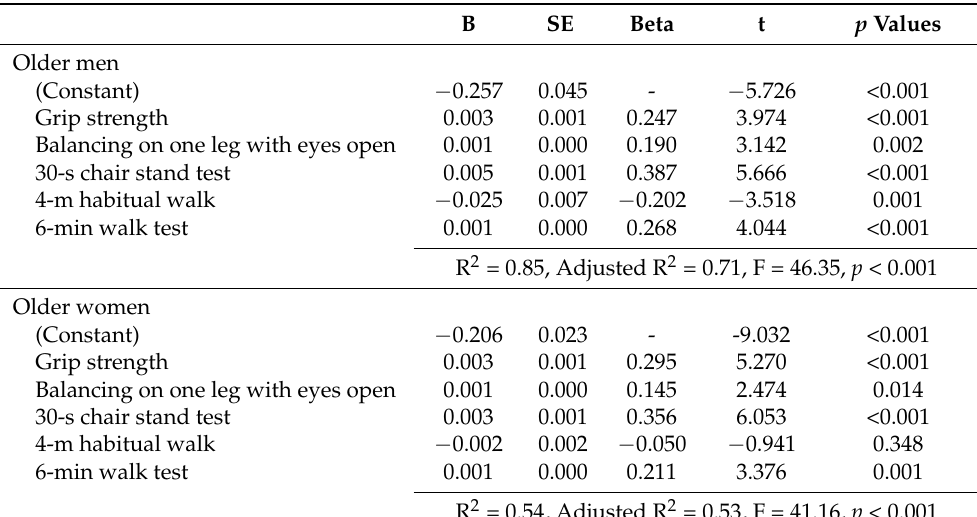
Table 3. The multiple linear regression analysis between the age discrepancy score and measured physical fitness items in older men and